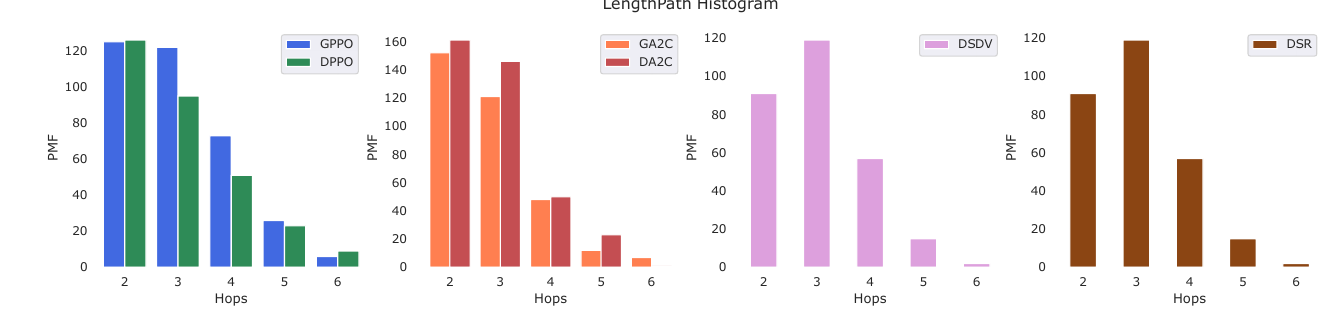
Figure 8. Histogram length of the path.